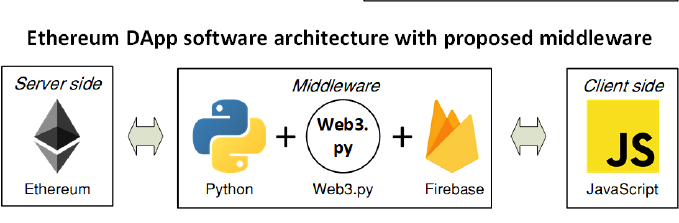
Figure 2. Ethereum software architecture comparison.